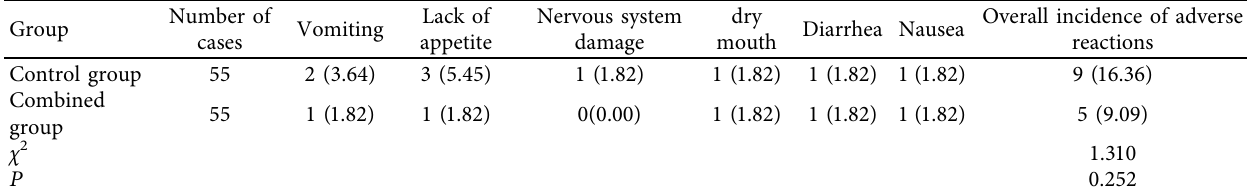
Table 5: Comparison of the total incidence of adverse reactions between the two groups ( n ,